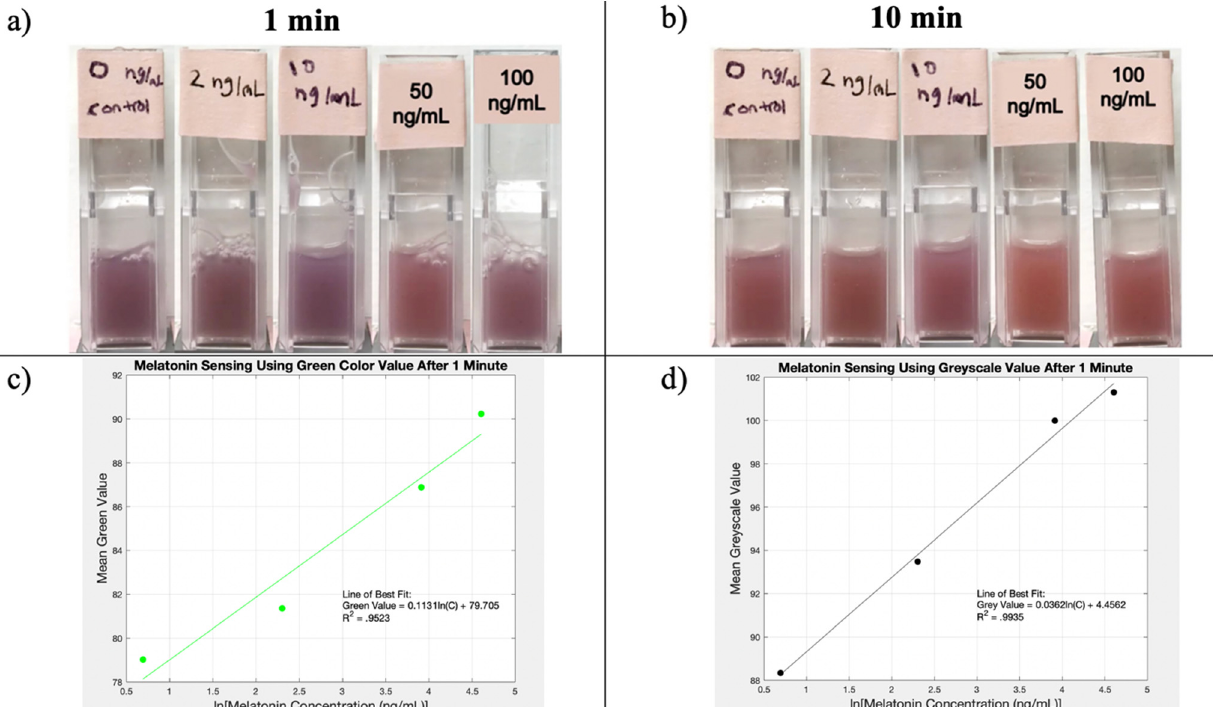
Figure 4. Results from the melatonin biosensing experiment including: ( a ) the melatonin sensing samples 1 min after addition of Congo Red Dye; ( b ) melatonin sensing samples 10 min after the addition of Congo Red Dye; ( c ) plot of mean green value vs. natural log of melatonin concentration based on the imaging of samples 1 min after addition of Congo Red Dye; ( d ) plot of mean grayscale value vs. natural log of melatonin concentration based on imaging of samples 1 min after the addition of Congo Red Dye. Graphs created on MATLAB.